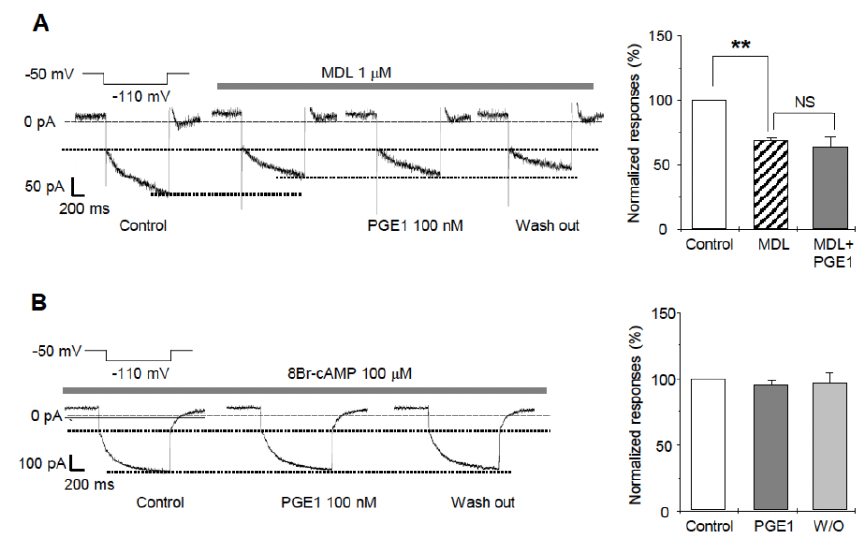
Figure 5. The effects of adenylyl cyclase inhibitor (MDL12330A) and 8Br-cAMP on PGE1-induced I h facilitation. ( A ) A representative recording of I h current after application of PGE1 (100 nM) in the presence of adenylyl cyclase inhibitor (MDL-12330A hydrochloride, 1 µ M). Summary for the effects of PGE1 on I h in the presence of MDL. I h was significantly inhibited by MDL and was not facilitated by PGE1 after the application of MDL. ( B ) A representative recording of I h after application of PGE1 (100 nM) in the presence of 8-Br-cAMP in the pipette solution. Summary for the effects of PGE1 on I h in the presence of 8-Br-cAMP. Results are presented as the mean ± SEM (** p < 0.001, paired t -test). MDL: MDL-12330A, NS; not